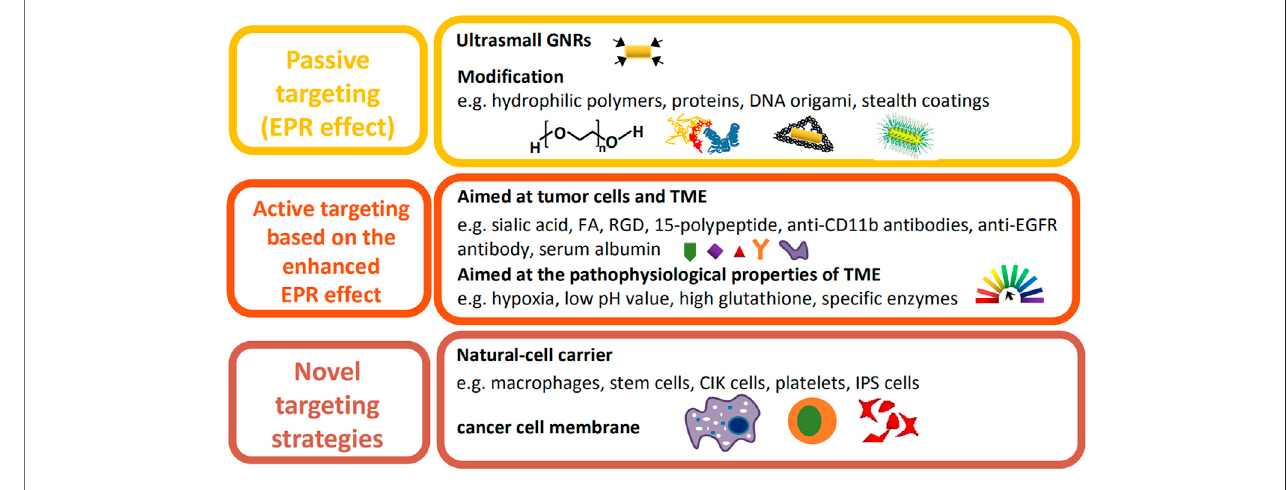
FIGURE 4 | Illustration of recent improvements on the tumor accumulation of GNRs.